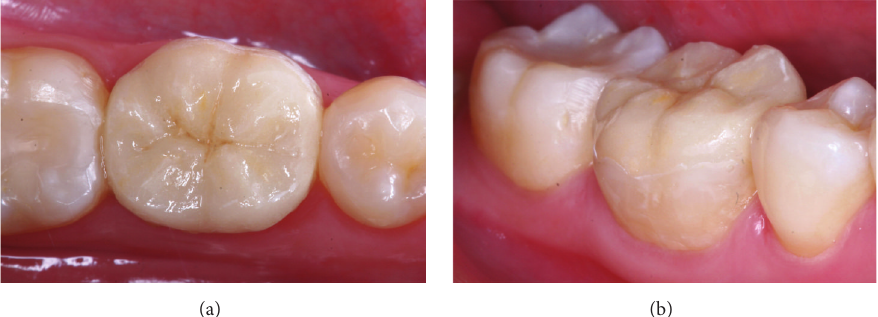
Figure 8: Final occlusal (a) and vestibular (b) view after bonding the endocrown using the VITA-PM9 system in a nonvital tooth.